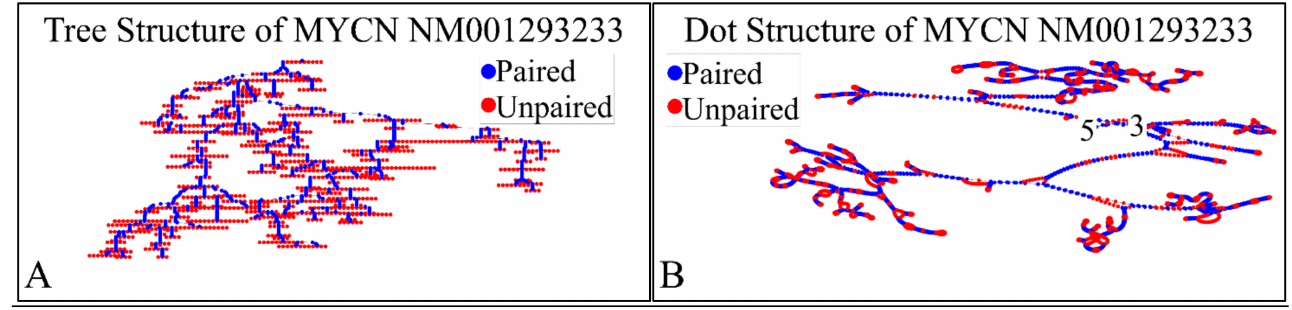
Figure 12. The predicted secondary structure of the MYCN , NM001293233 transcript. In particular, the tree structure ( A ) and the dot structure ( B ) of the transcript are presented (predictions were performed with the Matlab ® (The Mathworks, Inc. Natick, MA, USA), using the RNAfold method).